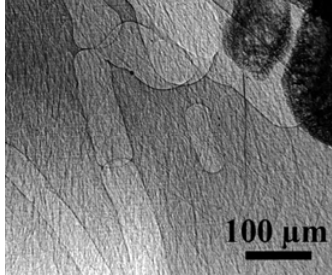
Figure 1. An example of the advanced capabilities of microradiology with spatially coherent synchrotron x-rays: the area near the ankle of a mouse, taken without any contrast agent [12] and revealing very small details. The image recording time was 30